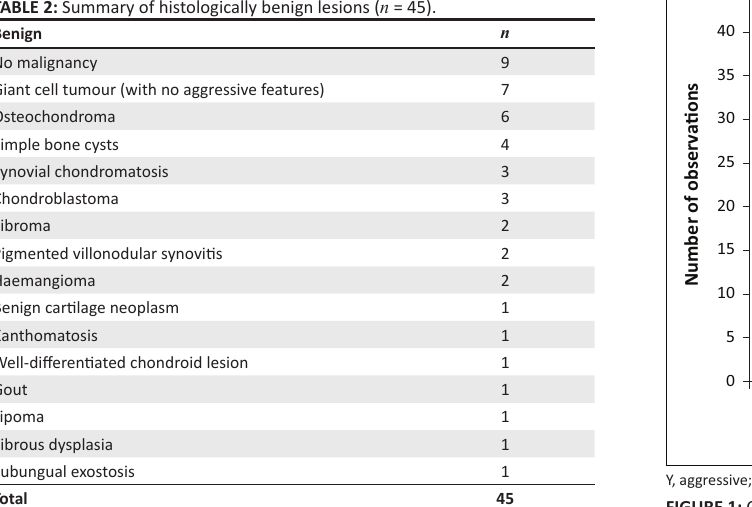
FIGURE 1: Comparison between the readers’ radiographic interpretations.